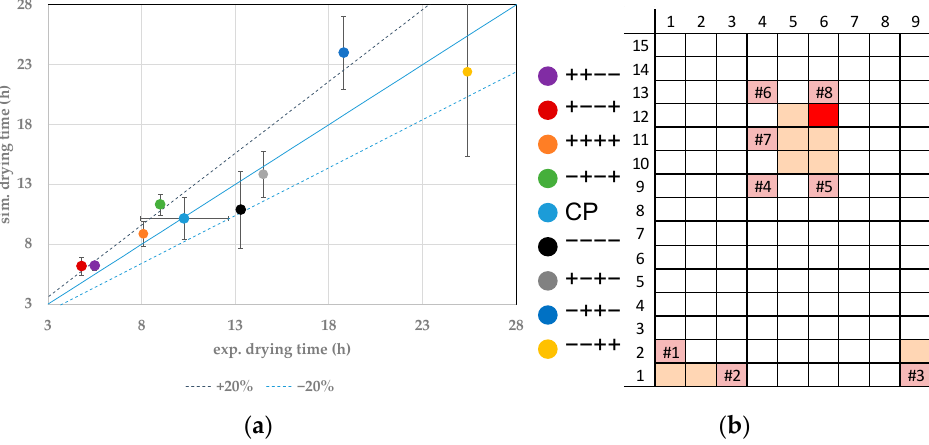
Figure 7. ( a ) Parity plot between simulated and experimental primary drying endpoints for vial 12.6. ( b ) Color legend for experiments and vial position (red: shown vial, orange: other probed vials, pink: WTMplus sensor position and WTMplus number).